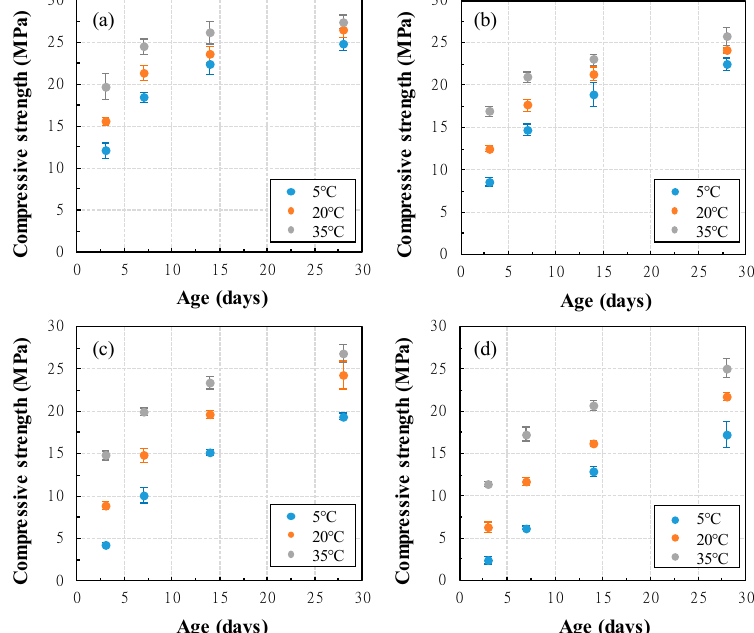
Figure 8. Compressive strength of concrete with curing temperature and GGBFS replacement ratio ( a ) 0%, ( b ) 10%, ( c ) 30%, ( d ) 50%.